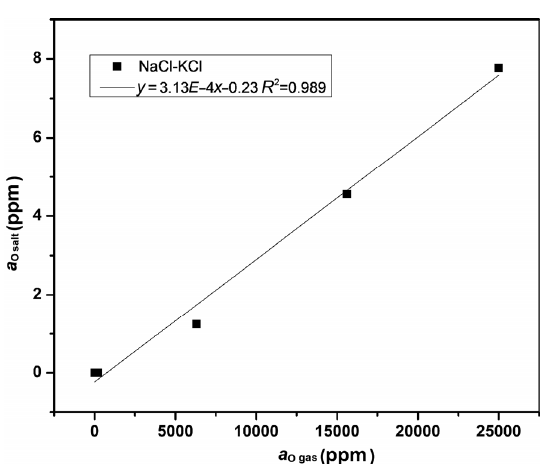
Fig. 4 Oxygen content ( a O salt ) of molten NaCl–KCl as a function of O 2 partial pressure ( a O gas ) in covering